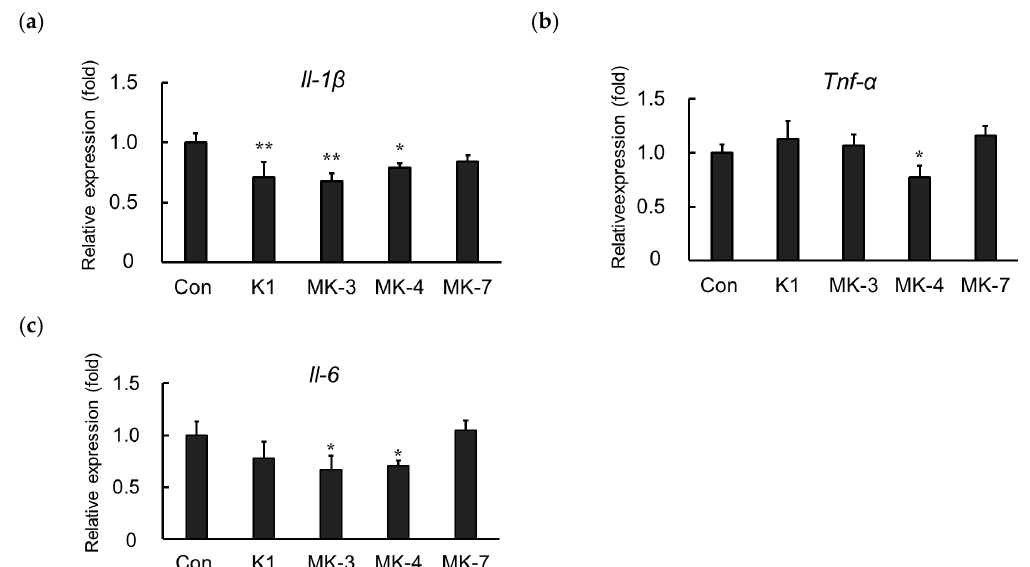
Figure 4. Vitamin K analogs have different effects on inflammatory cytokine expression. MG6 cells were treated with various vitamin K analogs for 24 h and subsequently exposed to LPS (1 ng/mL) for 3 h. The mRNA levels of proinflammatory cytokines were measured by quantitative reverse transcriptase-PCR, normalized to levels of Eef1a1 (the internal standard), and expressed as the fold-change relative to control cell values (cells not treated with MK-4). ( a ) Il-1 β levels, ( b ) Tnf- α levels, and ( c ) Il-6 levels. Data are presented as the mean ± S.E.M, n = 3. Values were significantly